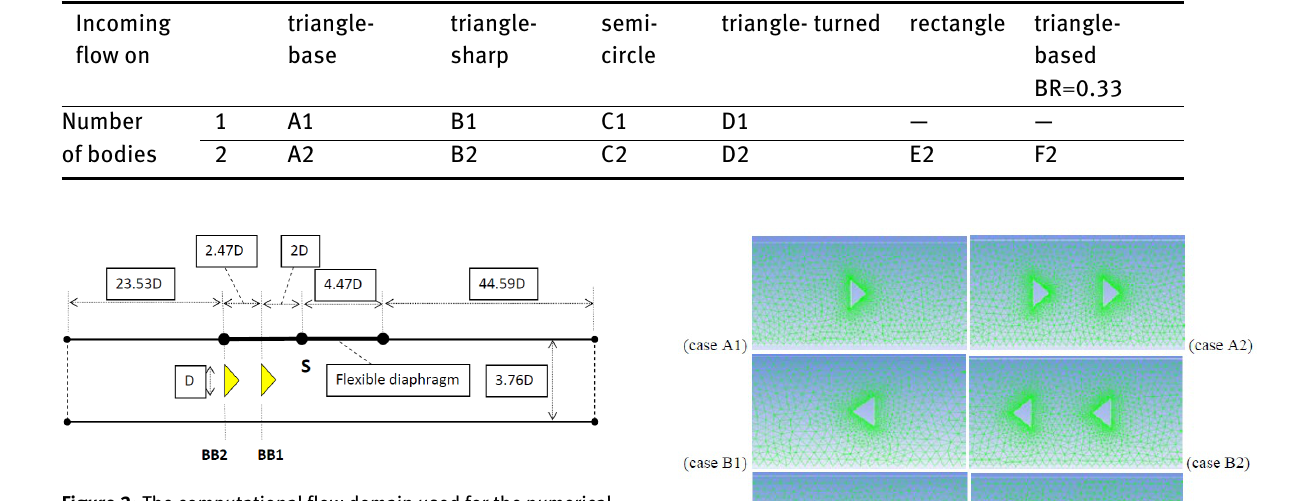
Figure 2: The computational flow domain used for the numerical simulations.